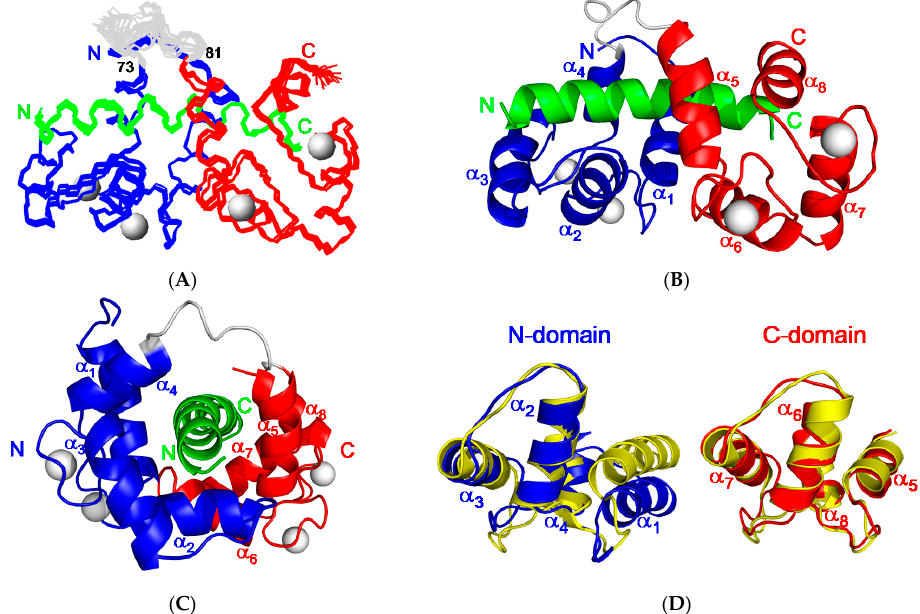
Figure 5. Solution structure of CaM in complex with CaNp. ( A ) The ensemble of 20 best structures of the complex of CaM and CaNp is superimposed. The backbone structures of the N-domain, C-domain, and tether region of CaM are colored coded in blue, red, and grey respectively. Ca 2+ ions are shown as grey spheres. The CaNp is colored coded in green. The N- and C-termini of CaM and CaNp are labeled as N and C respectively; ( B ) The ribbon representation of CaM/CaNp complex structure. The complex structure shows an ellipsoidal shape with 8 α -helices ( α 1 – α 8 ) of CaM wrapping the CaNp helix; ( C ) Side view of the ribbon representation of CaM/CaNp complex structure. CaNp shows a curved helical conformation centered at the residue Gly 404 ; ( D ) The structural changes of the two domains of CaM upon binding to CaNp. The structure of free CaM (in yellow) superimposed with the structure of CaM when associated with CaNp. The N-domain and C-domain of CaM in the bound form is colored in blue and red respectively. N-domain of CaM, especially helix I ( α 1 ) undergoes larger structural changes upon association with CaNp, whereas C-domain of CaM remains unchanged.